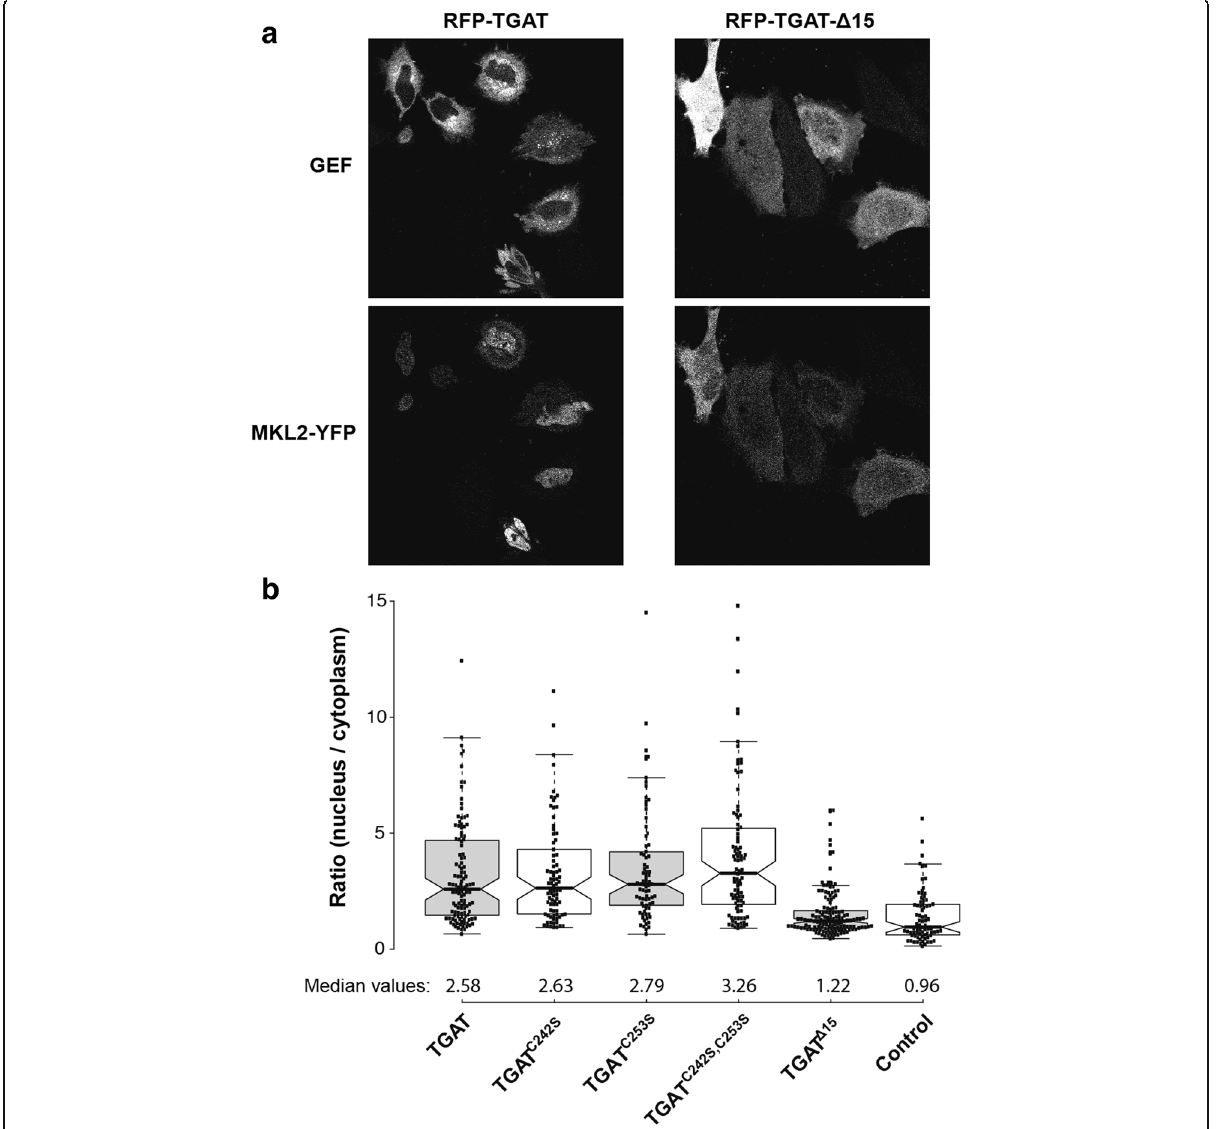
Fig. 6 Effect of TGAT mutant expression on nuclear MKL2 translocation. a Representative images of HeLa cells co-transfected with YFP-MKL2 ( bottom ) and RFP-TGAT or RFP-TGAT Δ 15 ( top ). b Quantification of the ratio between nuclear and cytoplasmic MKL2-YFP fluorescence in HeLa cells transfected with RFP-TGAT ( n =116), RFP-TGAT C242S ( n =82), RFP-TGAT C253S ( n =77), RFP-TGAT C242S, C253S ( n =95), RFP-TGAT Δ 15 ( n =142) or RFP (control, n